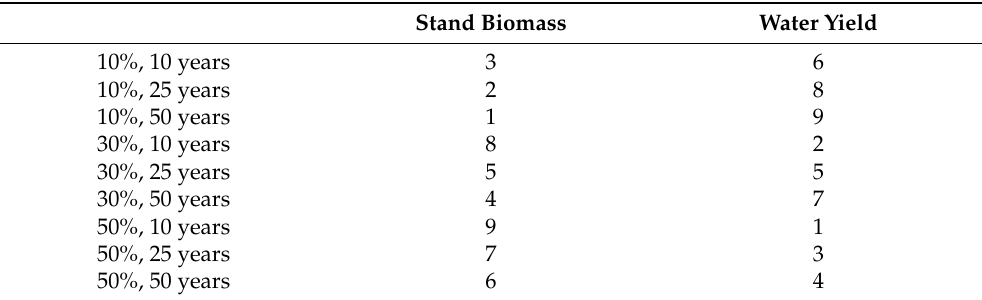
Table 6. Ranking of thinning regimes based on accumulated biomass and water yield. Stand Biomass Water Yield 10%, 10